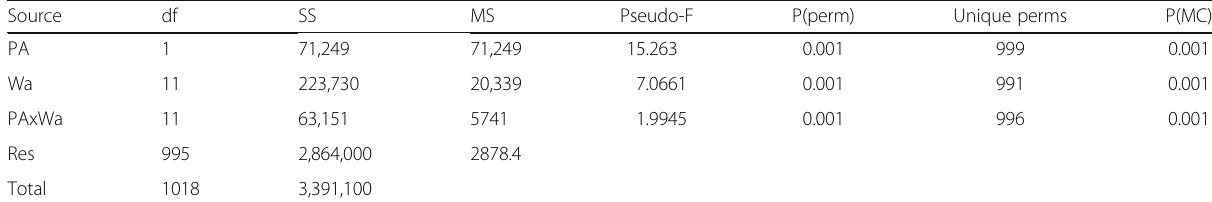
Table 2 Results of the PERMANOVA test to estimate the effect and spatial variation of D. geminata on the diatom community in Chilean rivers. The sources of variation considered in the analyses were PA: Presence / Absence of D. geminata , Ba: basins, the combined factor PAxBa and Res: Residuals